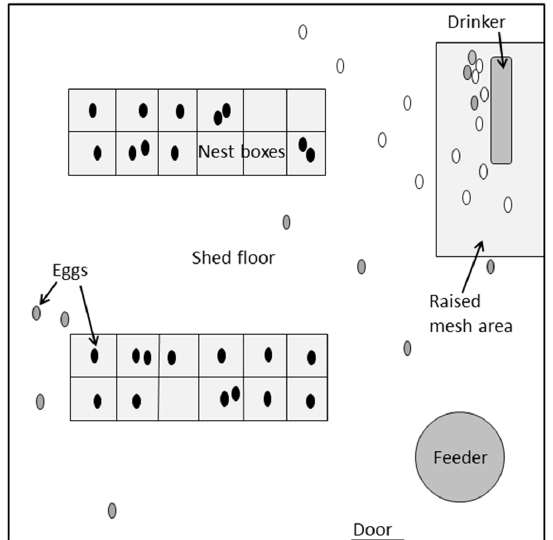
Figure 1. Schematic diagram of the pen layout used for video recording pre-laying behavior and the egg-laying locations of analyzed birds. Pen dimensions 5 m × 5 m. Black ovals = eggs laid in nest boxes; grey ovals = eggs laid on floor by ducks that used nest boxes; white ovals = eggs laid on the floor by ducks that did not use nest boxes.